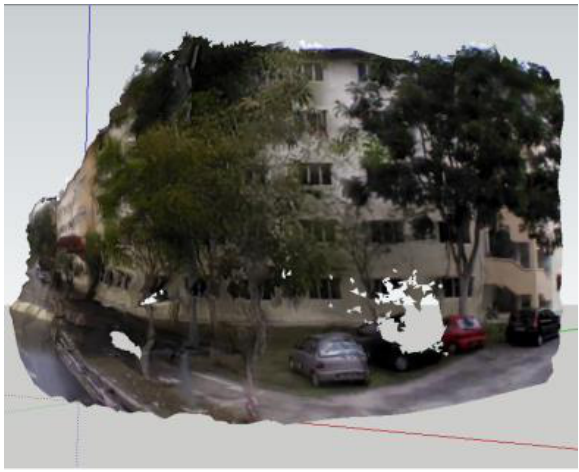
Figure 4. Low quality 3D model along with all the obstacles such as trees and vehicles after editing via SketchUp